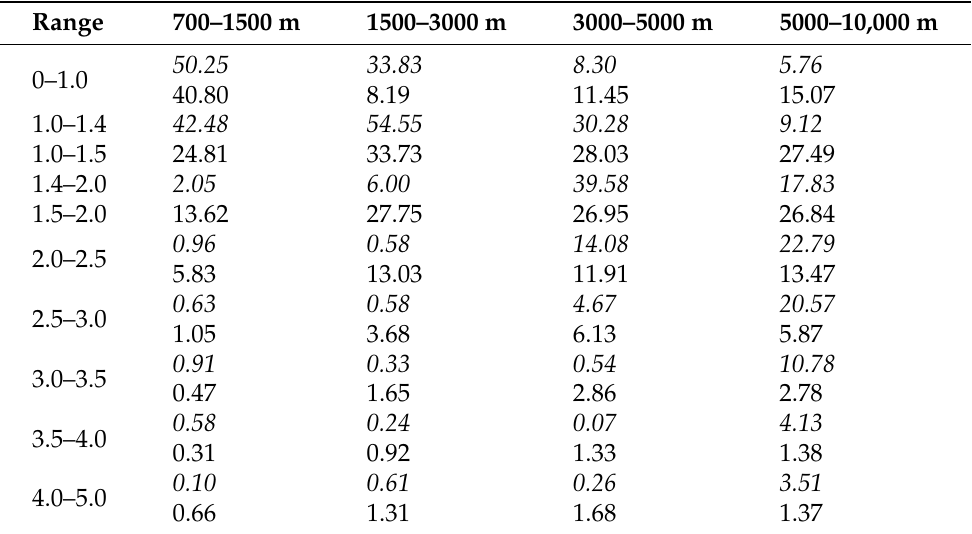
Table A4. Comparing the depolarisation ratios of Müller (2018) of the 1–13 March 2018 with the data from this study, considering all available data for March 2019. The first value in each cell (in italic ) represent the data of Müller (2018), the second value represents the data found in this study. The ranges of the second and third differed slightly in the study of Müller compared to this study.